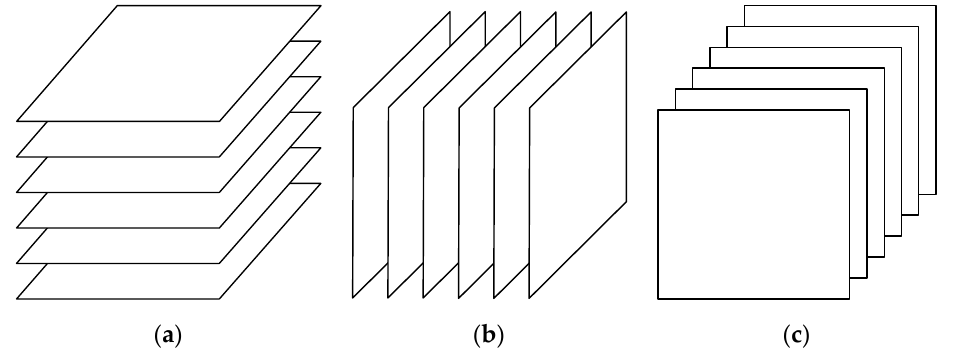
; ( b ) Lateral ; ( b ) Lateral (cid:3117) ∶ ∶ 1 : :